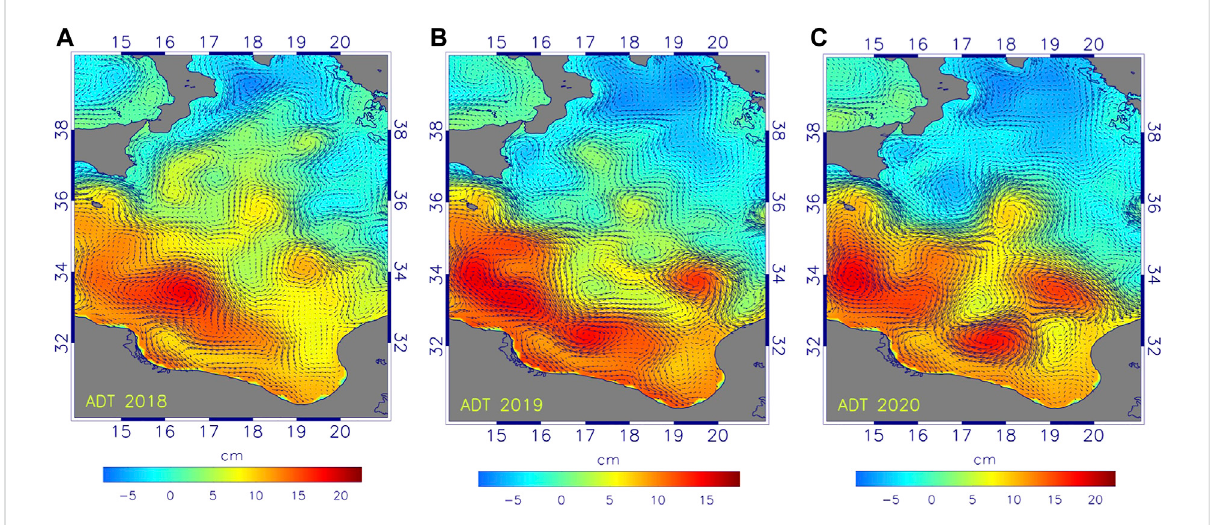
FIGURE 7 Average ADT maps in the Ionian region, for the years 2018 (A) 2019 (B) and 2020 (C) , with the corresponding geostrophic circulations superimposed. The anticyclonic cell still present in the northern Ionian in 2018 is rapidly destroyed.